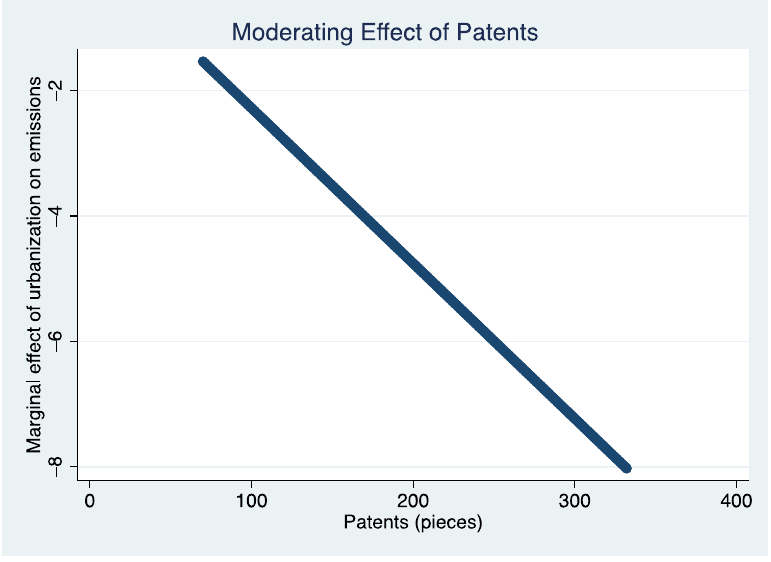
Figure 6. Moderating effect of patents.